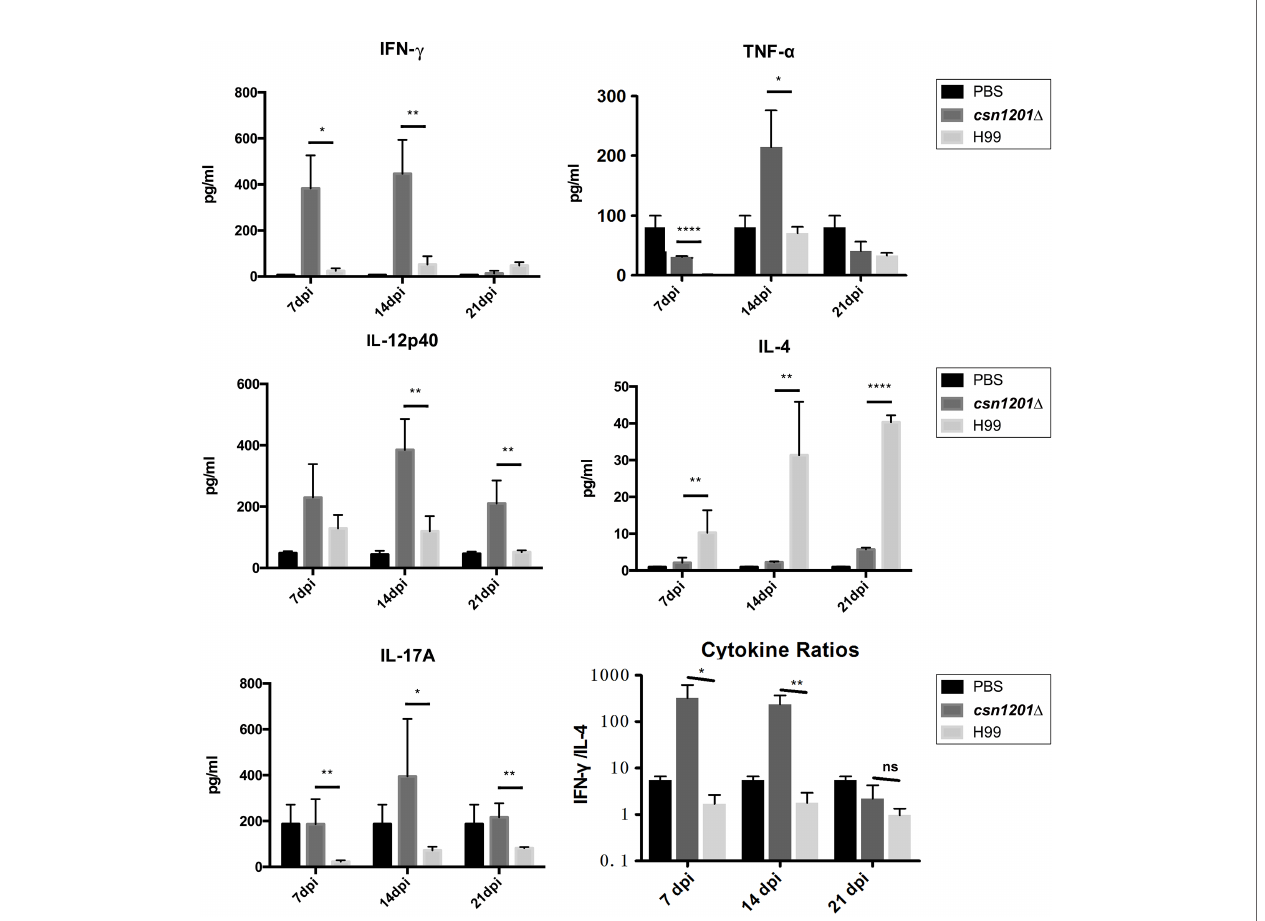
FIGURE 9 | The CSN1201 deletion promotes robust development of pulmonary Th1 and Th17 cytokine bias during cryptococcal infection. Speci fi ed in fl ammatory cytokines of C. neoformans- infected mice were analysed using ELISA. The Th1/Th2 bias ratio was calculated as IFN − g /IL − 4. Values are the mean ± SEM, n = 4 or more mice per group. *, P < 0.05; **, P < 0.01; ****, P < 0.0001; ns, no signi fi cant difference.